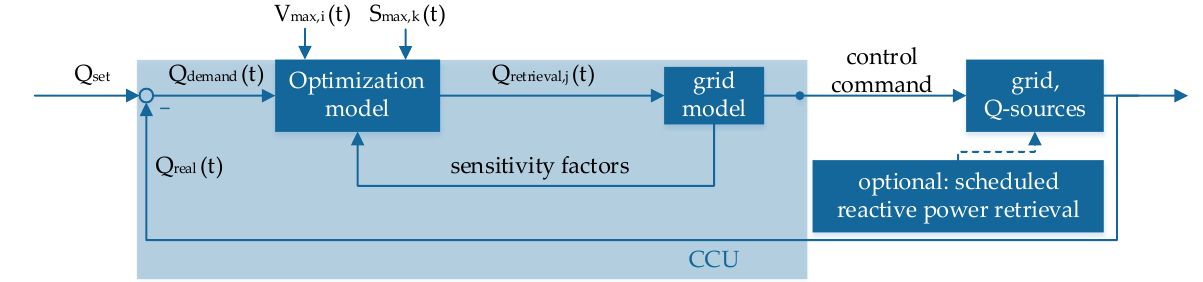
Figure 5. Control process of the central optimal reactive power control strategy.